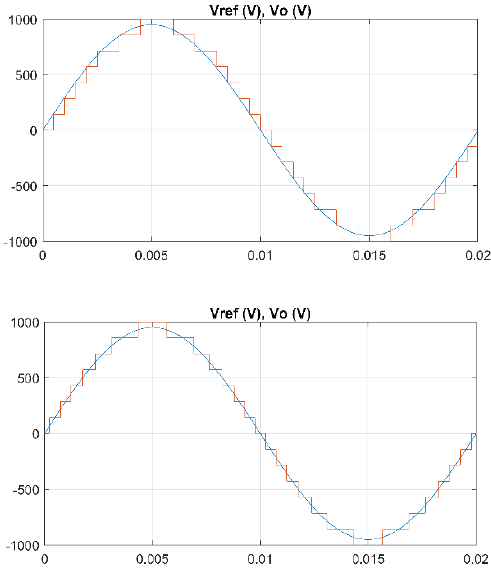
Figure 2. ( Top ) Reference voltage and near level control (NLC) voltage graphs when the switching period is fixed. ( Bottom ) Reference voltage and near level control (NLC) voltage graphs when the switching period is variable [21].